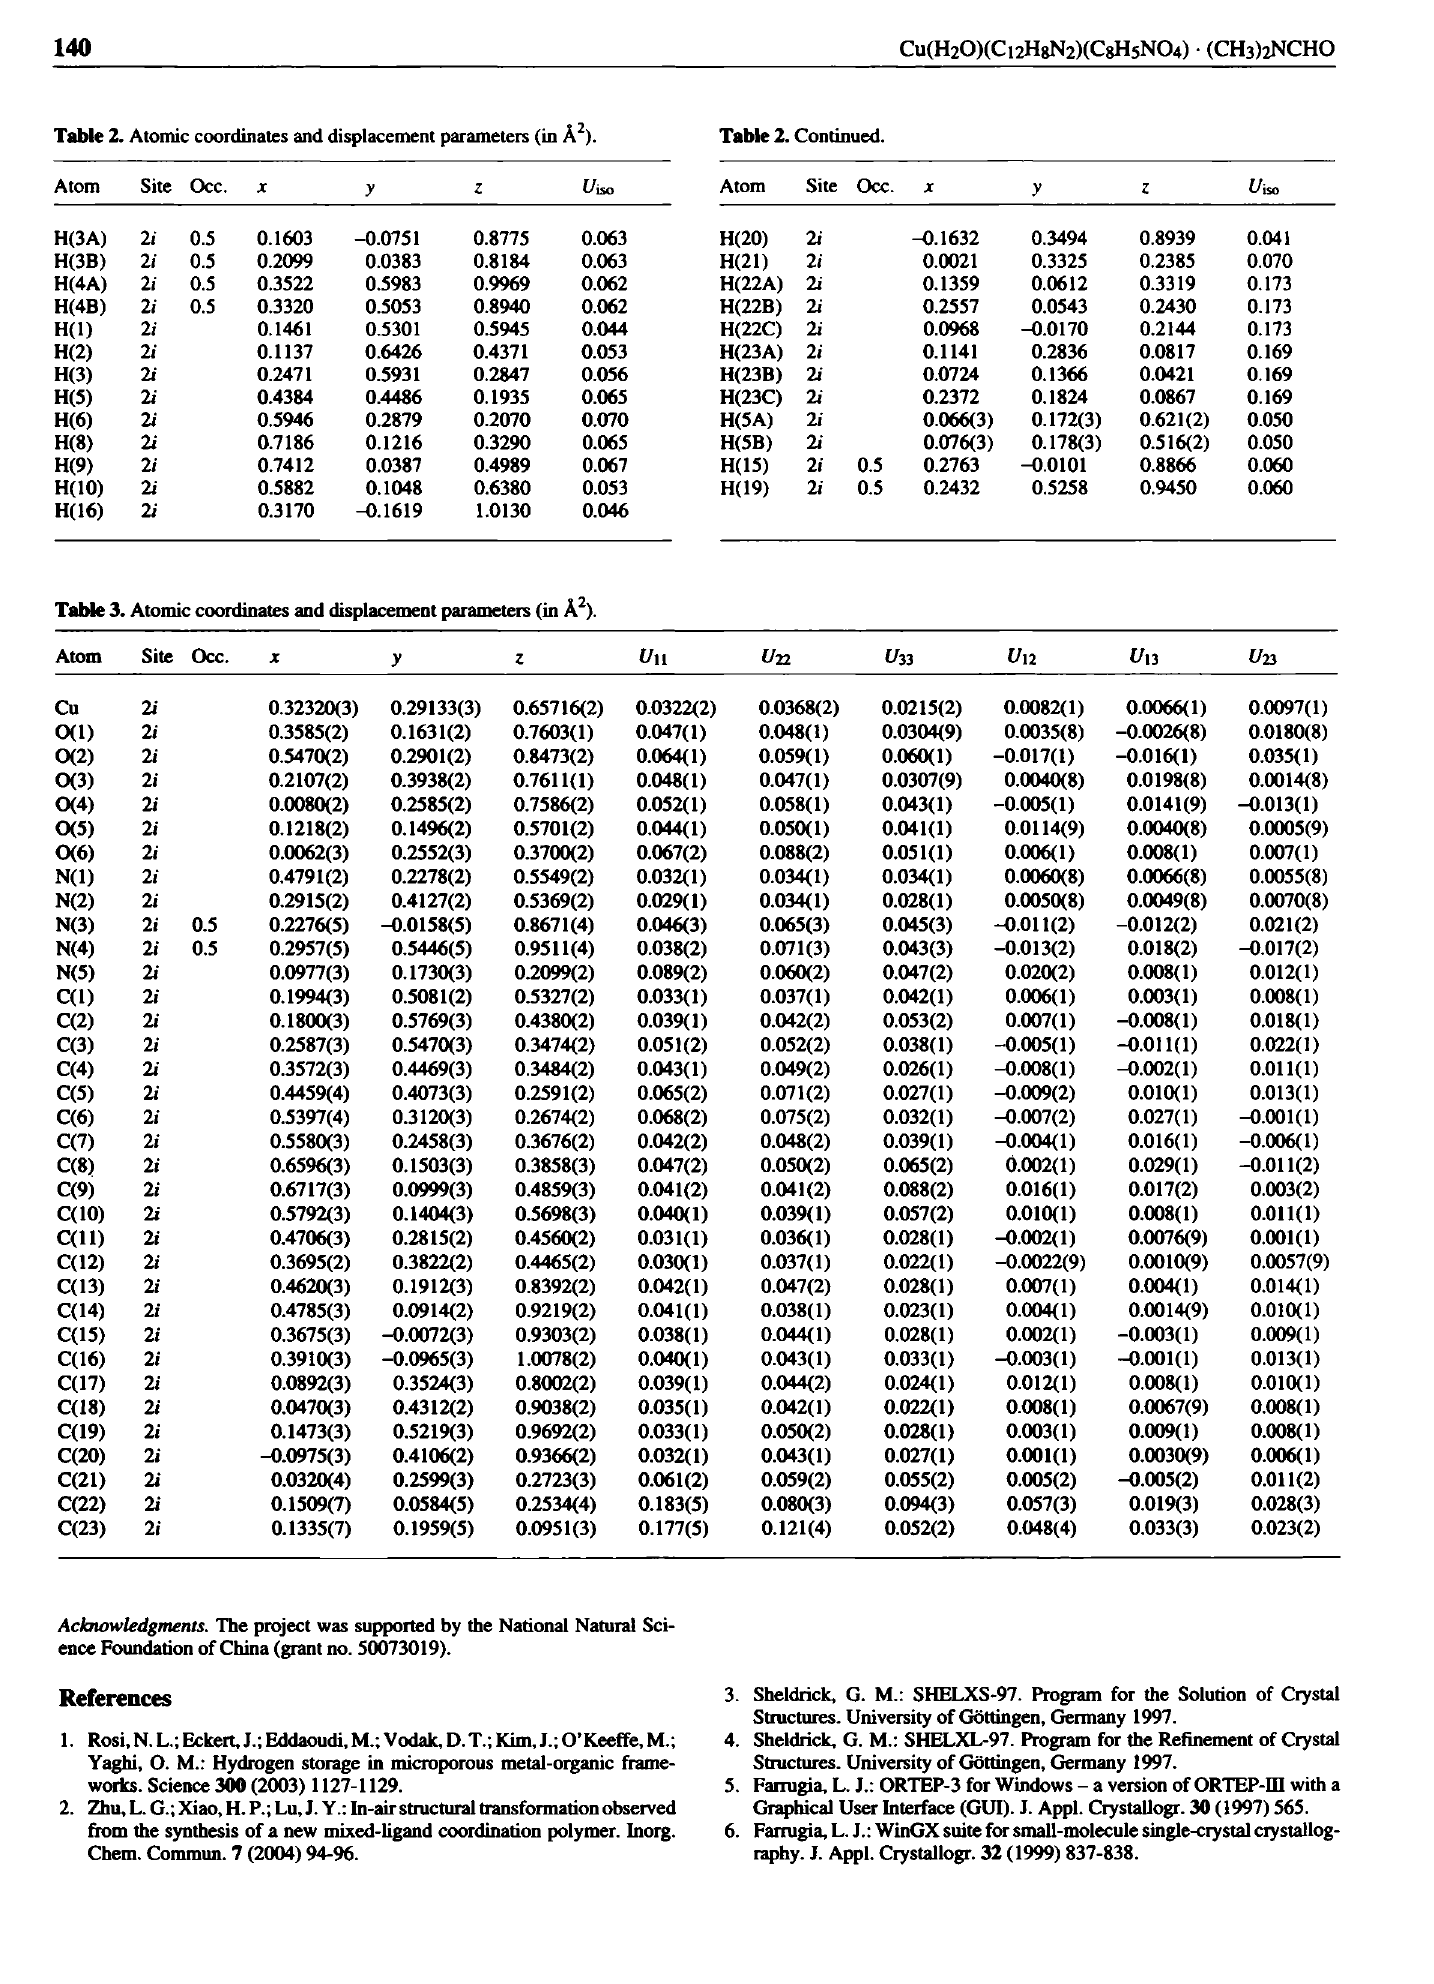
Table 2. Atomic coordinates and displacement parameters (in Ä 2 ). Atom Site Occ.